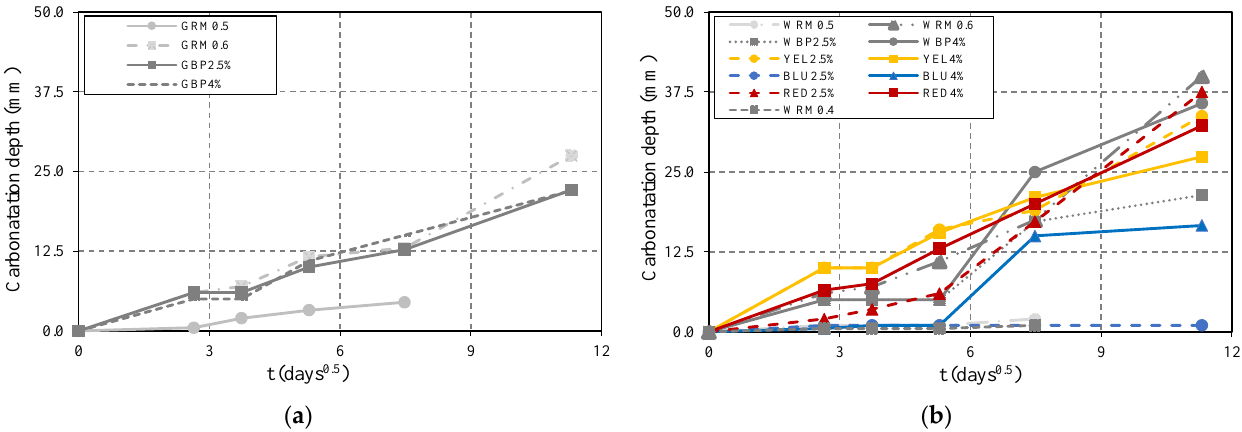
Figure 3. Evolution of the carbonation depth with the square root of time t (days): ( a ) GRM0.6, GRM0.5, GBP2.5%, GBP4%; ( b ) WRM0.6, WRM0.5, WRM0.4, WBP2.5%, WBP4%, YEL2.5%, YEL4%, BLU2.5%, BLU4%, RED2.5%, RED4%.